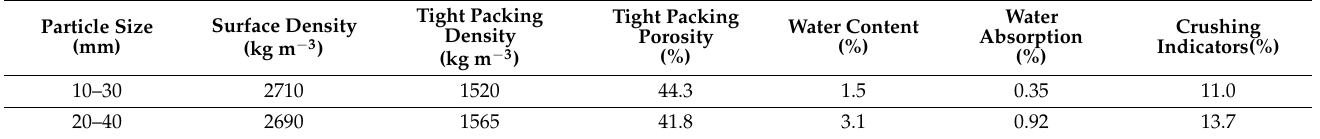
Table 3. Physical properties of aggregates.